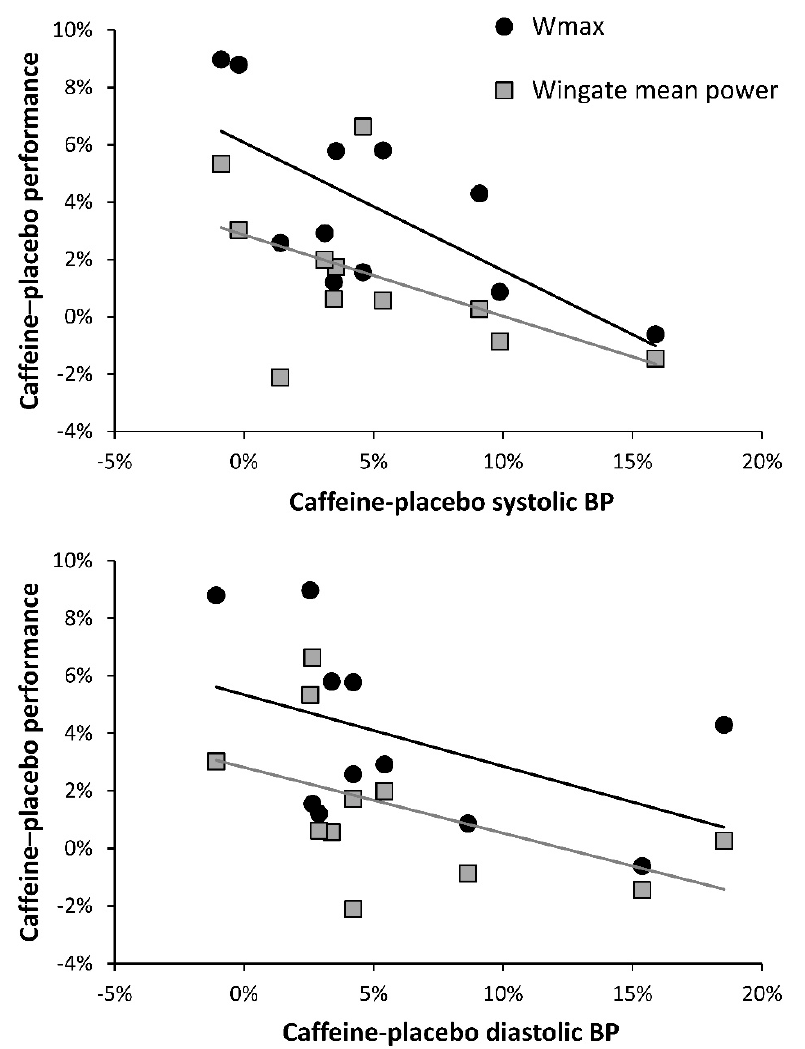
Figure 3. Relationships between the ergogenic effect of caffeine and systolic (upper panel) and diastolic (lower panel) blood pressure (BP). The ergogenic effect of caffeine was obtained by measuring peak cycling power during a graded exercise test (Wmax) and during a 15-second Wingate test. Caffeine was compared to a placebo on eight different occasions and each dot represents an average of these eight caffeine–placebo comparisons for each participant.